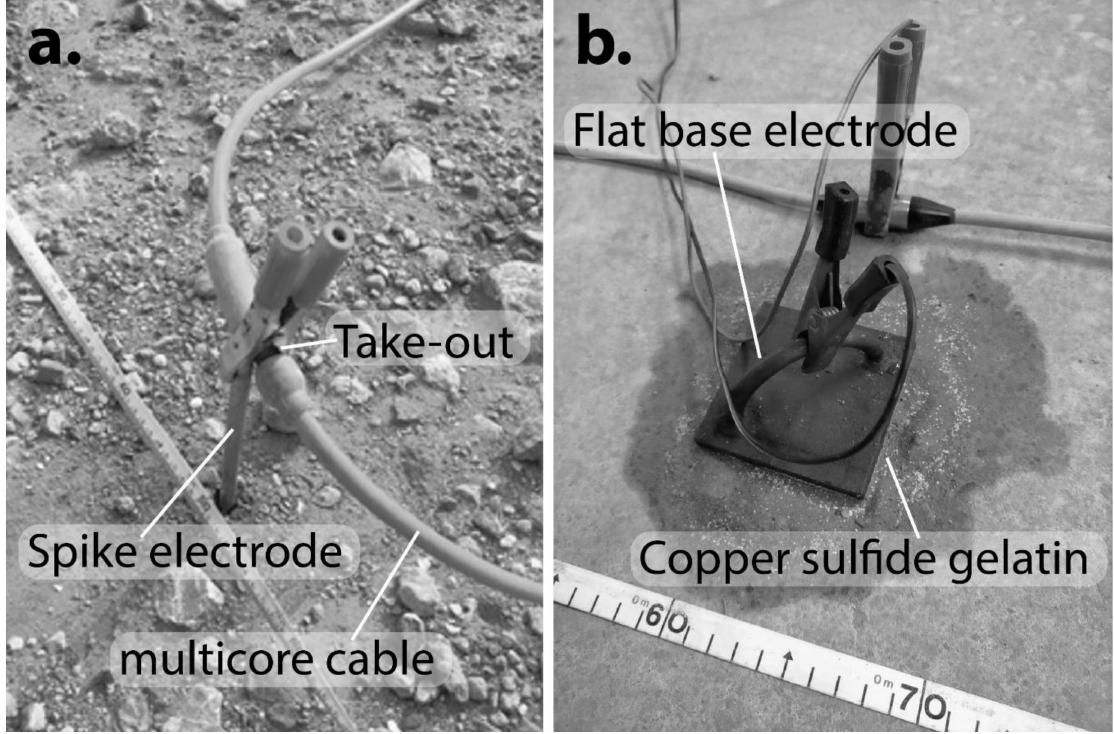
Figure 1. Electrodes used in electrical resistivity tomography (ERT) studies: ( a ) traditional spike electrode, and ( b ) flat-base